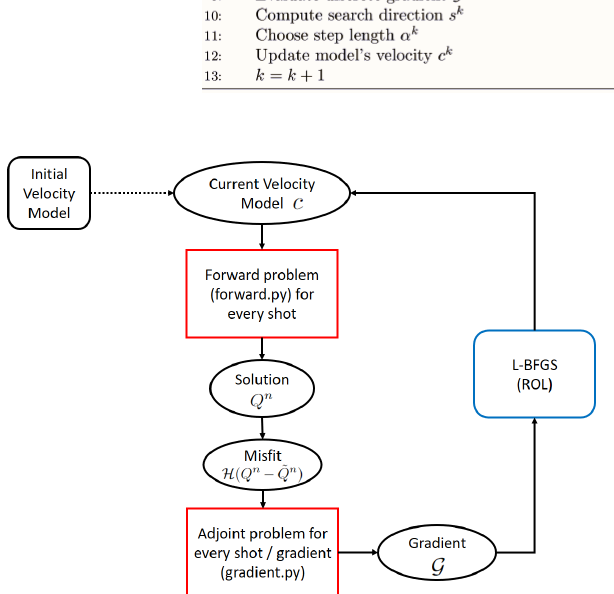
Figure 5. The functionality of the forward-state, adjoint-state, and gradient Python